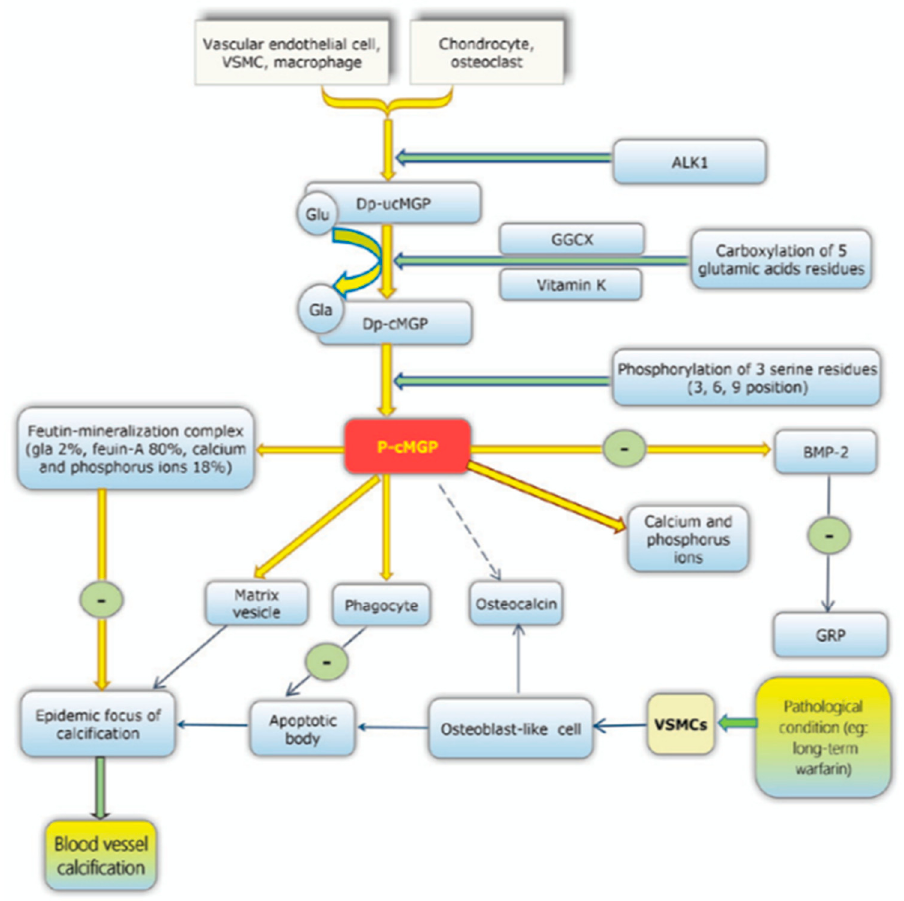
Figure 3. Progression of vascular calcification. This process highlights the importance of carboxylated MGP in its ability to adopt its properties once vitamin K and GGCX do so. However, once the MGP protein becomes phosphorylated, it then has specific physiological functions, such as inducing phagocytes to remove apoptotic bodies, chelating to calcium and phosphorus ions and stimulating the production of osteocalcin, which all prevent the calcification of vessels. Bone Mineral protein (BMP), Gla-rich protein (GRP), Vascular smooth muscle cells (VSMCs) [17]. MGP can also be activated through the phosphorylation of three serine